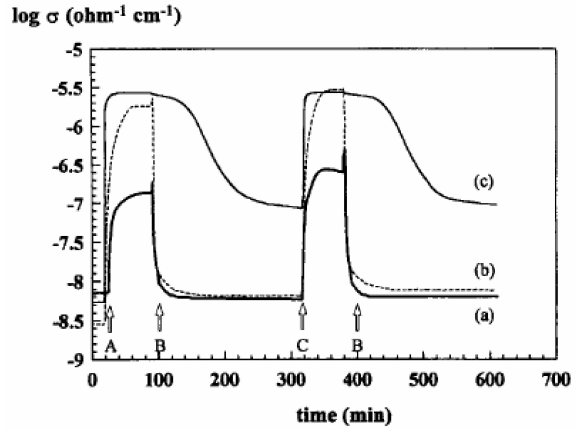
Figure 10. Variations of electrical conductivity during redox cycles [66] Copyright 2015, Elsevier BV: ( A ) at 500 ˝ C for 14V/VMgO, ( B ) at 800 ˝ C for 14 V/MgO and ( C ) for 45 V/MgO. (a) C 3 H 8 /O 2 = 1.2/1; (b) vacuum; and then O 2 ; (c) C 3 .